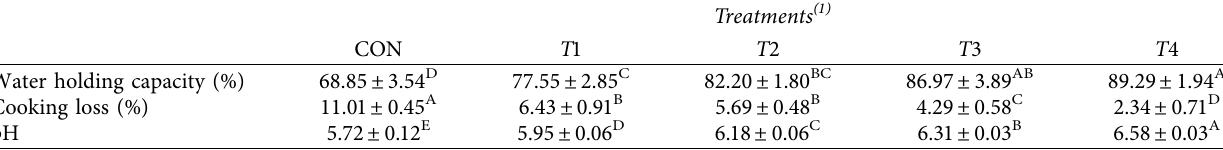
Table 3: Water holding capacity, cooking loss, and pH of the hybrid beef patty with shiitake mushroom ( Lentinus edodes ).